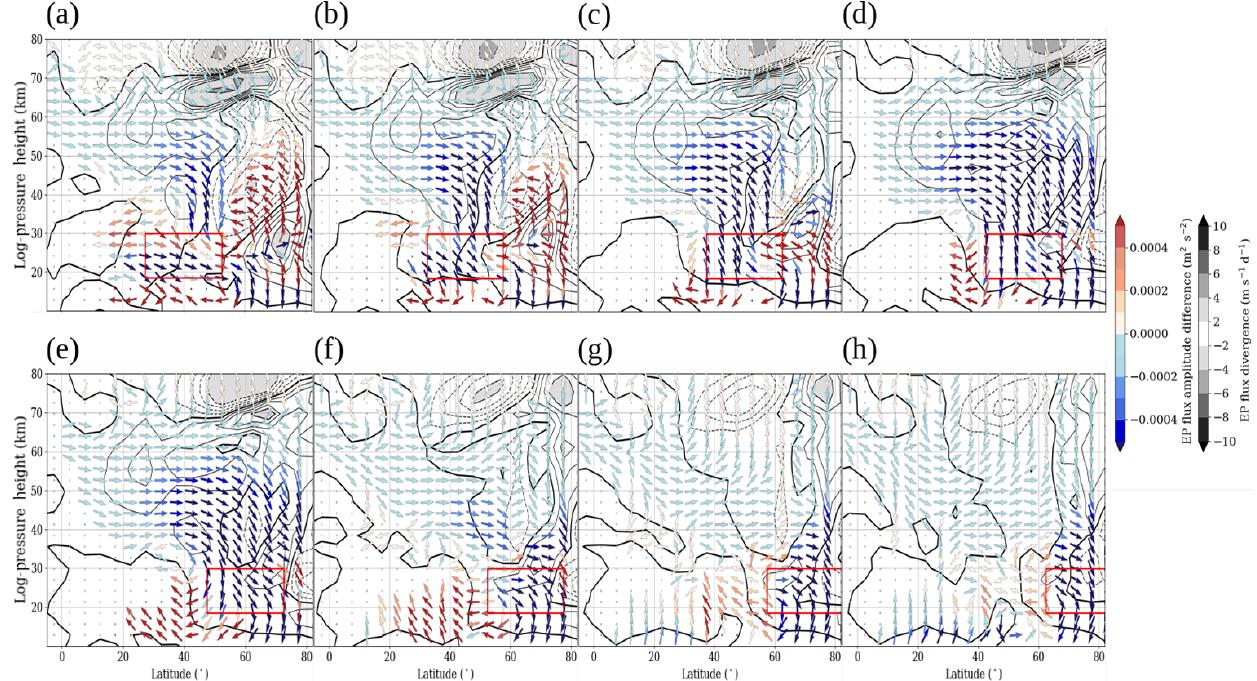
Figure A1. Zonal mean EP flux (arrows) and divergence (isolines and shaded areas; dashed lines show negative values) of SPW 1. Shown is the difference between all H1–H8 (a–h) simulations and the reference simulation (H1–H8 − Ref) representing the last 30d of the simulations. The EP flux is weighted by the